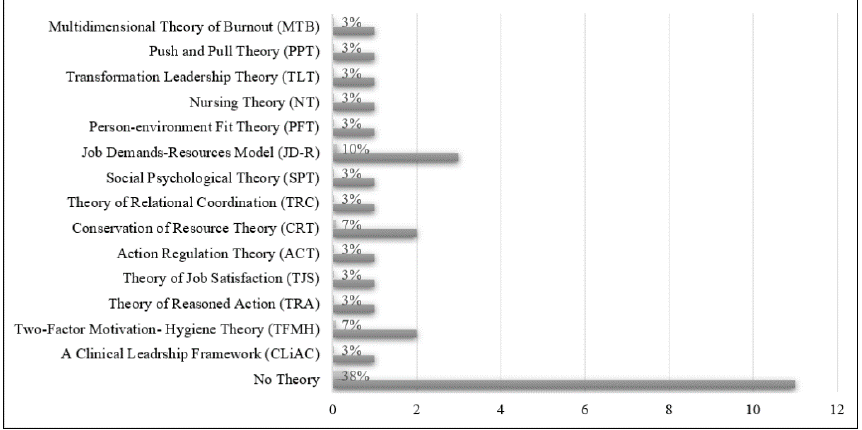
Figure 2. Underpinning theories/frameworks in the reviewed articles.